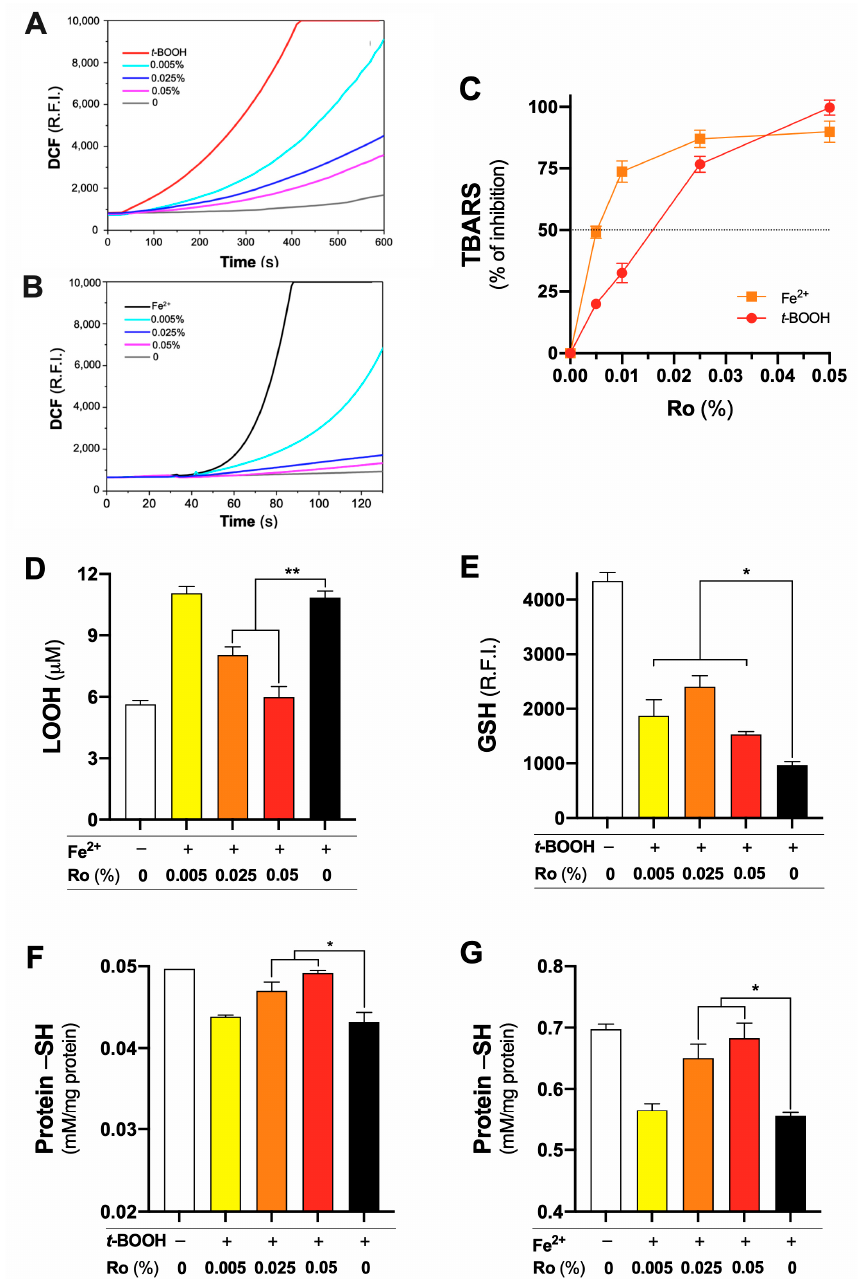
Figure 1. Glycolic extract of Rosmarinus officinalis ( Ro ) protects isolated rat liver mitochondria from oxidative stress. Mitochondria (1.0 mg/mL) were energized by succinate (site II substrate) in the presence of rotenone. DCF fluorescence was recorded kinetically using 0.6 mM t -BOOH (( A ), red line) or 50 mM Fe 2+ (( B ), black line) as inducers of oxidative stress. Ro concentrations are represented by cyan (0.005%), blue (0.025%), and magenta (0.05%) lines. The inhibitory effect of Ro on the lipid oxidation (TBARS) induced by Fe 2+ (squares, orange line) or t -BOOH (circles, red line). Effects of different concentrations of Ro on the formation of lipid hydroperoxides (LOOH) induced by Fe 2+ ( D ), GSH oxidation induced by t -BOI ( E ), and oxidation of protein thiol groups induced by t -BOOH ( F ) or Fe 2+ ( G ). In ( D – G ), negative control (absence of Fe 2+ and Ro ) is represented by white bars, positive control (Fe 2+ or t -BOOH) by black bars, and the effects of Ro by yellow (0.005%), orange (0.025%), and red (0.05%) bars. In ( C – G ), data are presented as mean ± SD of three independent experiments. Statistical differences are indicated by * ( p < 0.05) and ** ( p <